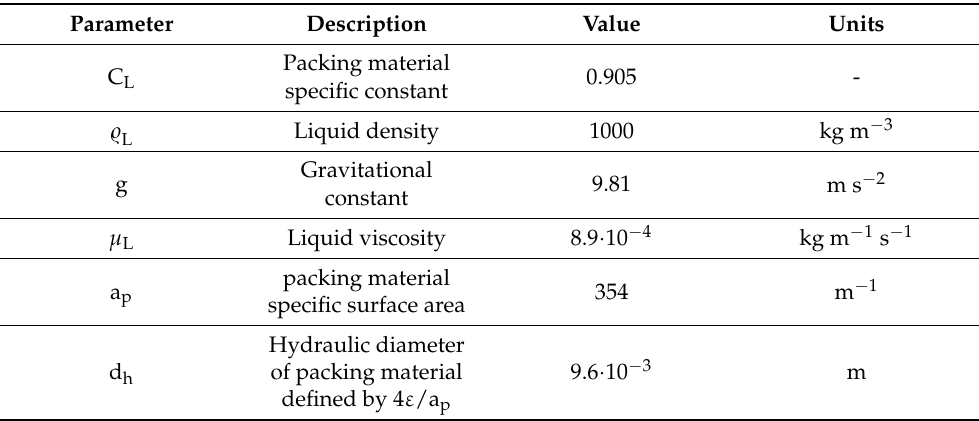
Table A1. Constants needed for the Billet and Schultes mass transfer correlation.